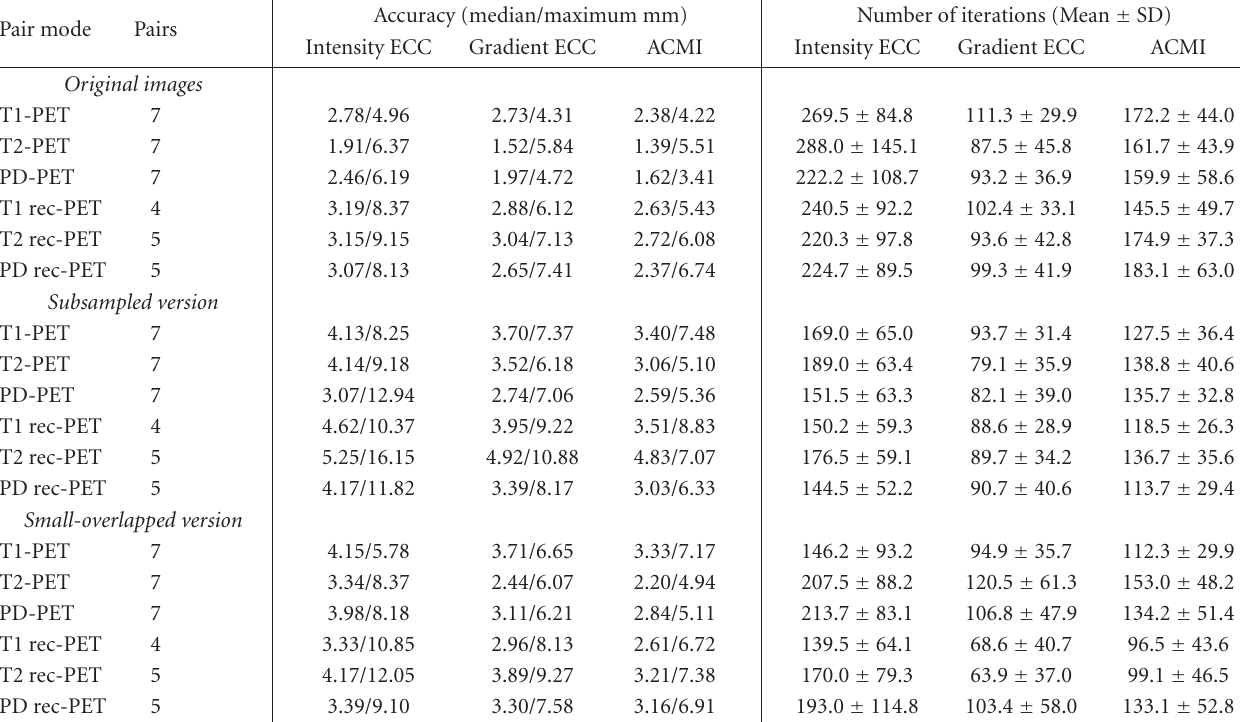
Table 2: Accuracy and iterative number comparison among intensity ECC, gradient ECC, and